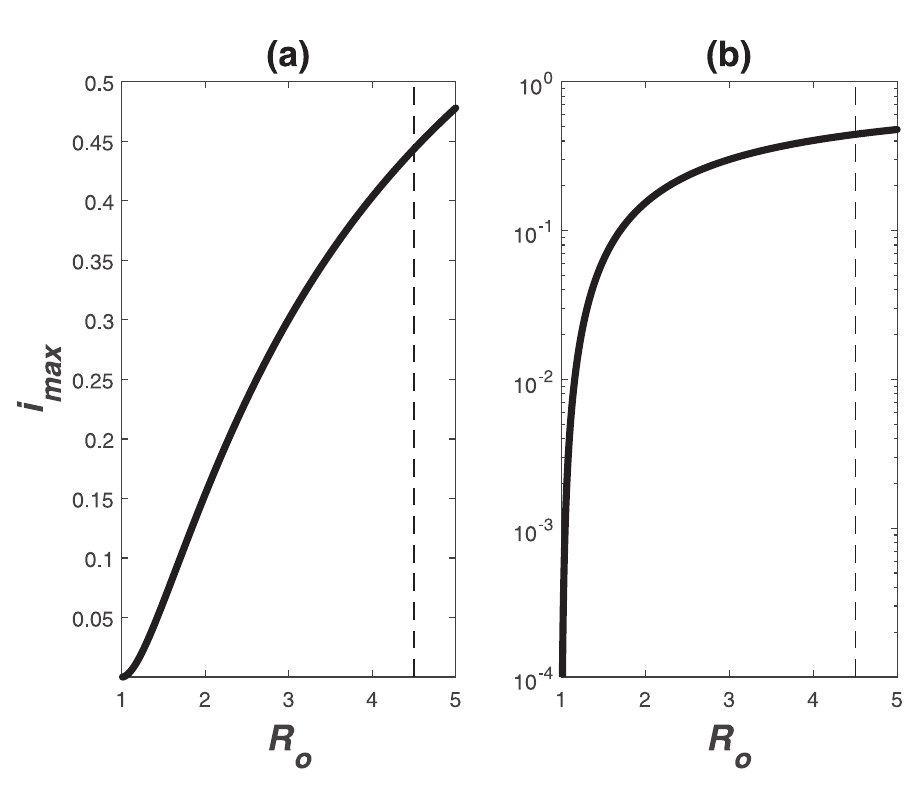
= I / S and R max max o o